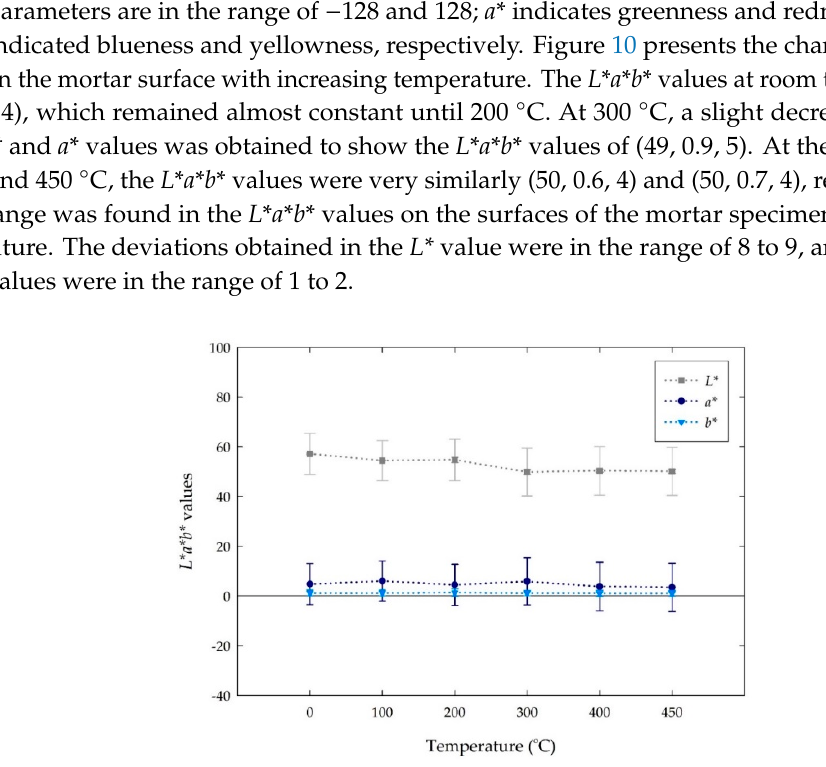
Figure 10. Color changes on the mortar surfaces obtained in L * a * b * values.